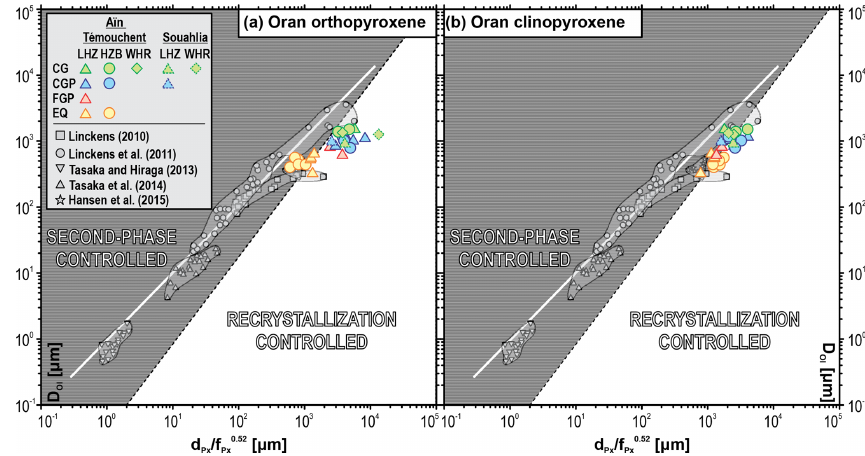
Figure 8. (a) Zener diagram showing average area-weighted olivine grain size ( D Ol ) as a function of grain size and volume fraction of pyroxene ( d Px /f 0 . 52 ) in the Oran mantle xenoliths. Data are plotted considering orthopyroxene (a) and clinopyroxene (b) as secondary Px phases in the olivine matrix. The diagram shows the transition from second-phase (grey-shaded field) to dynamic recrystallization (white- shaded field) controlled microstructures after Herwegh et al. (2011). Comparative data are from natural peridotite shear zones in the Oman ophiolite (Linckens, 2010; Linckens et al., 2011a, b; Tasaka et al., 2014) and the Josephine peridotite (Hansen et al., 2015), as well as deformation experiments on olivine–pyroxene aggregates (Tasaka and Hiraga, 2013). For plotting the data, a Zener parameter of Z = 0 . 52 is used following Tasaka et al. (2014), and the solid white line in the background is the fit presented in their work. Abbreviations in the legend are the same as for Fig.